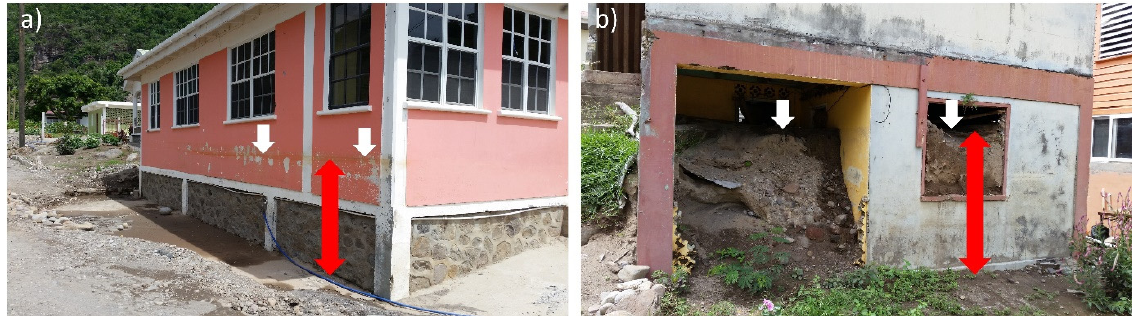
Figure 4. ( a ) Sediment deposition height measured from marks on the walls. The white arrows show the deposition/flooding marks on the wall and the red arrow is the measured deposition/flooding height. ( b ) Sediment deposition height measured from remaining sediments inside a building. The white arrows show the deposition surface inside the building and the red arrow is the measured deposition height.